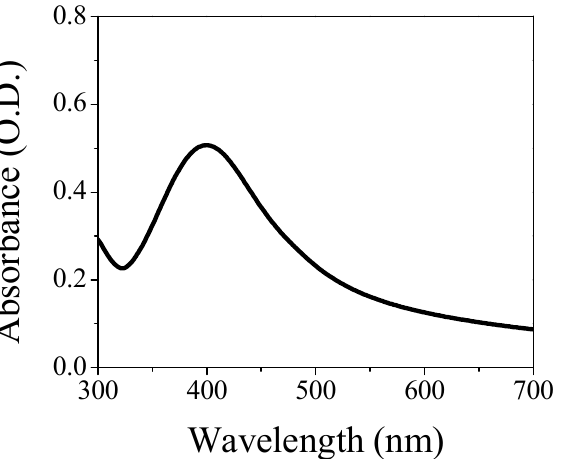
Figure 1. Optical absorption in the UV-Vis range of the AgNPs/L-cys/citr colloidal solution. The nanosystem is tested in presence of Cd(II) and As(III). In the case of cadmium cations, the concentration was in the range from 1–25 ppm. Figure 2a shows the UV-Vis absorption spectroscopy of the colloidal solution as a function of Cd(II) content. The peak position shifts toward longer wavelengths (red-shift) increasing the contaminant concentration (for concentration higher than 10 ppm). Moreover, a broadening of the absorption band is also recorded. Figure S1 shows the maximum wavelength of the plasmon band as a function of Cd(II) concentration. Three different regions can be observed: below 5 ppm the AgNPs are not able to detect the presence of cadmium; between 7.5 and 17.5 ppm the optical sensor exhibits a linear behavior, and above 17.5 ppm the system’s saturation occurs. The limit of detection (LOD, 3 σ ) and the limit of quantification (LOQ, 10 σ ) can be determined from the linear fit in the linear region. We obtained 9 ppm and 12 ppm as LOD and LOQ, respectively. Although the sensitivity is not very high compared with the literature [25–27], and thus the use as an optical sensor for cadmium ions is limited, the interaction between the capping molecules and the contaminating ions is genuine and occurs, even at low concentrations. This prerogative is of fundamental importance; in fact, by exploiting this interaction the system has the potential use as a filter to remove pollutants from the water. A further step is the insertion of our system inside a hydrogel-based matrix for the synthesis of a filter able to remove these toxic ions, improving the applicability and handling in real conditions. The AgNPs/L-cys/citr are also tested in presence of 5, 10 and 25 ppm of As(III), but the LSPR band does not suffer any change in terms of intensity, peak position and band broadening. Figure 2b reports the optical behavior of this nanosystem polluted with 25 ppm of